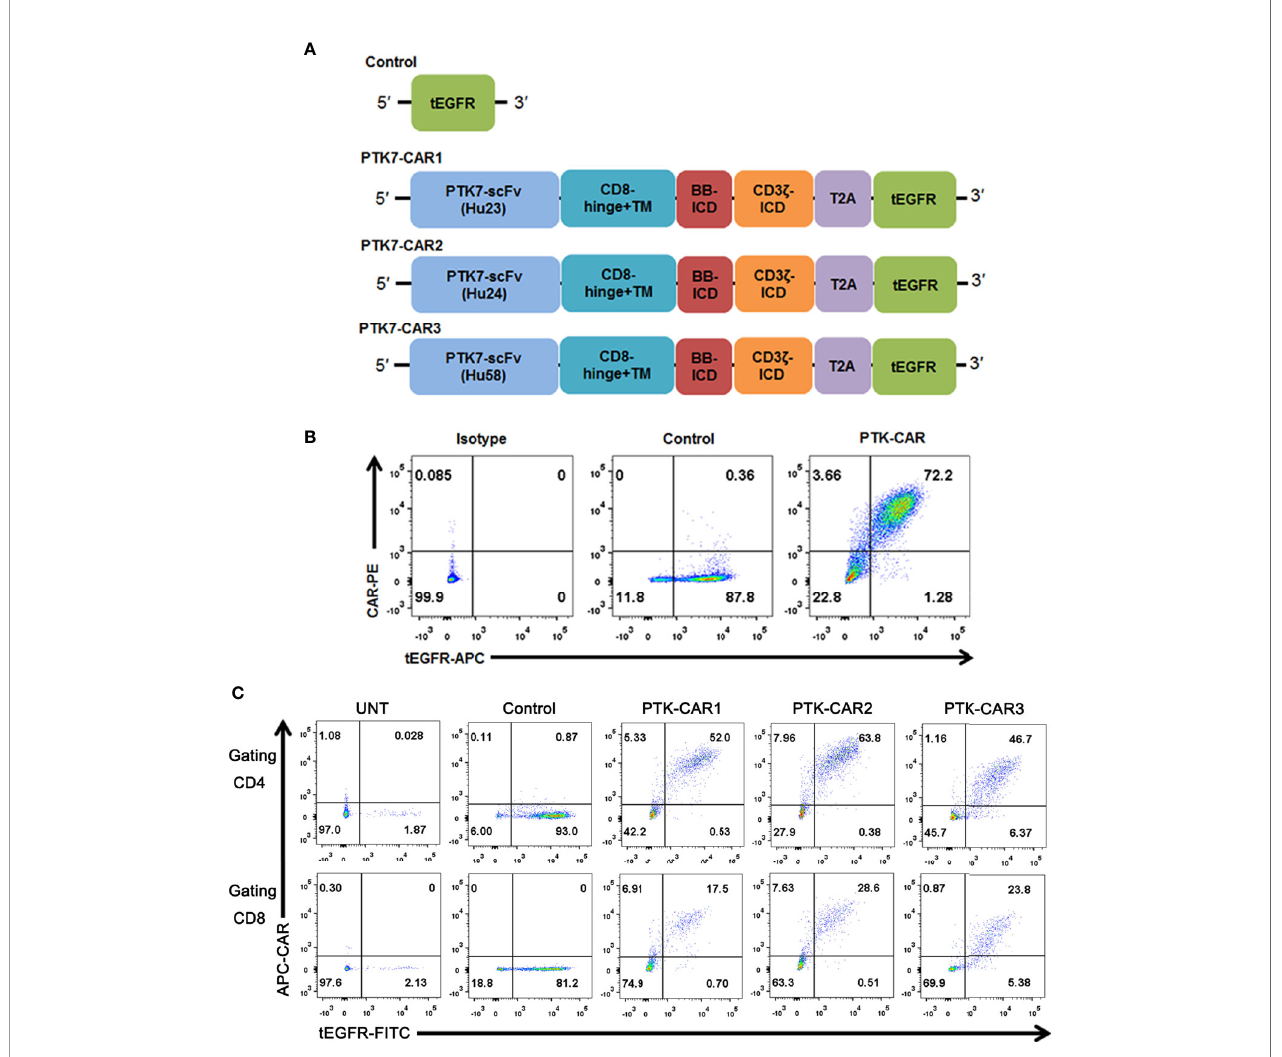
FIGURE 1 | PTK7-CAR generation, cell-surface expression, and transduction of human T cells. (A) PTK7-CAR was generated by fusing PTK7-speci fi c scFv to the co- stimulatory signaling domain of the 4-1BB (BB-ICD) and activating signaling domain of CD3 z (CD3 z -ICD), a T2A ribosomal skipping sequence, and tEGFR was included for the detection of CAR-modi fi ed T cells. (B) 293T cells transfected with control or PTK7-CAR constructs express both CAR and the marker gene tEGFR. (C) PTK7-CAR expression on transduced human CD4 + and CD8 + T cells was approximately 40 – 60% and 20 – 30%, respectively, as determined by tEGFR and CAR